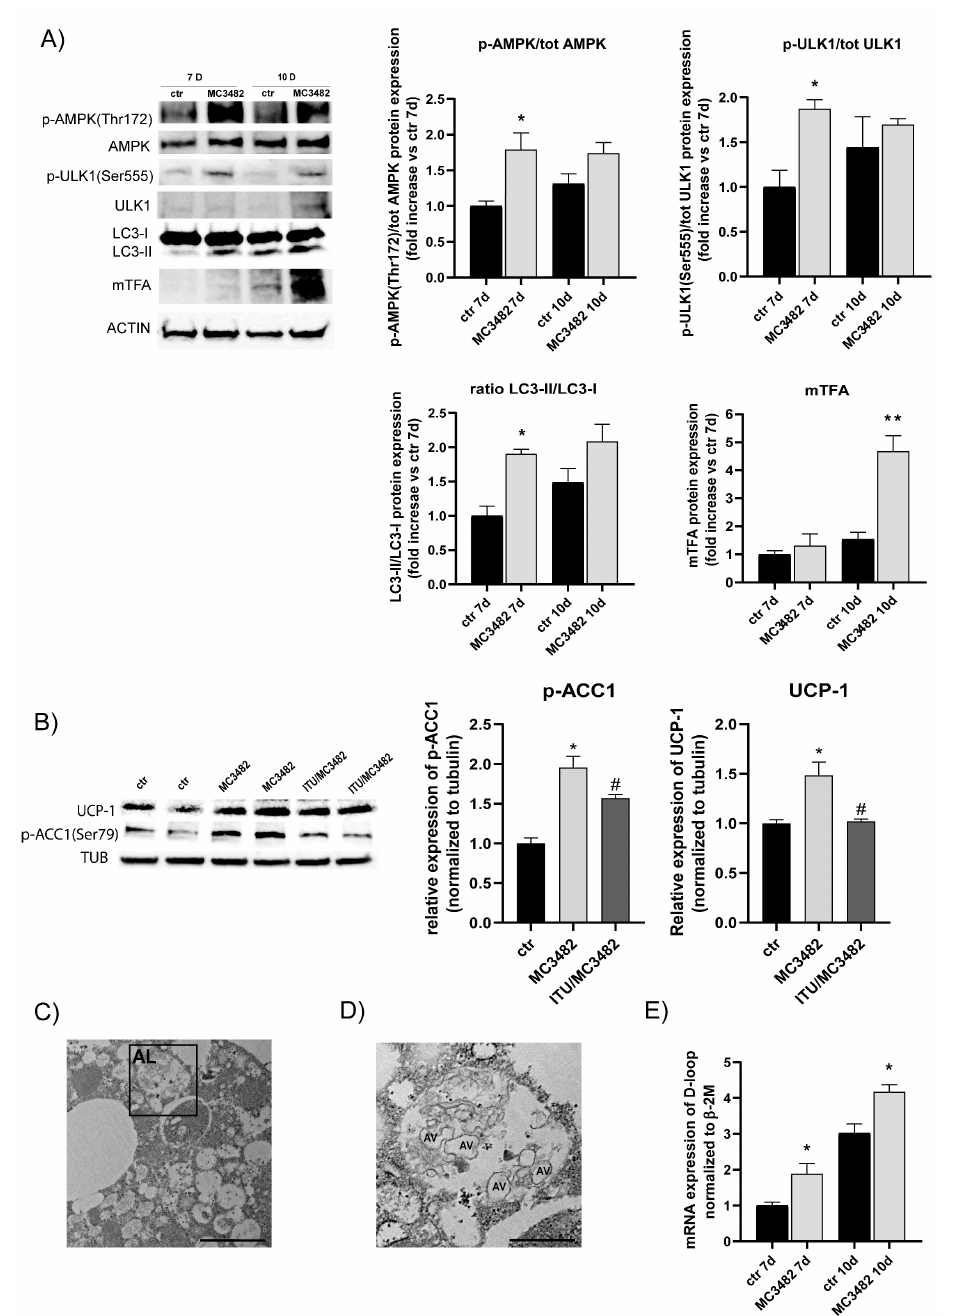
Figure 4. Effects of MC3482 treatment on autophagy and mitochondrial abundance. ( A ) Western blot analysis in 3T3-L1 cells treated with or without MC3482, for AMPK, authophagic and mitophagic markers, and mTFA at day 7 and 10 of differentiation. ( B ) Western blot analysis of UCP-1 and p-ACC1 at day 10 of 3T3-L1 cell differentiation upon treatment with vehicle (ctr), MC3482 or with MC3482 and the AMPK inhibitor 5-iodotubercidin (ITU). ( C ) Representative TEM images showing autophagolysosomal (AL) membranes in 3T3-L1 cells upon MC3482 treatment. Scale bar = 2 µ m. ( C ) Enlargement of AL in ( D ), autophagic vacuoles are indicated as “AV”. Scale bar = 600 nm. ( E ) Relative mitochondrial DNA content measurements performed by qPCR. Values are expressed as means ± SEM of 3 independent experiments. * p < 0.05, ** p < 0.01 vs. untreated control (ctr), # p < 0.05 vs. MC3482, at corresponding time